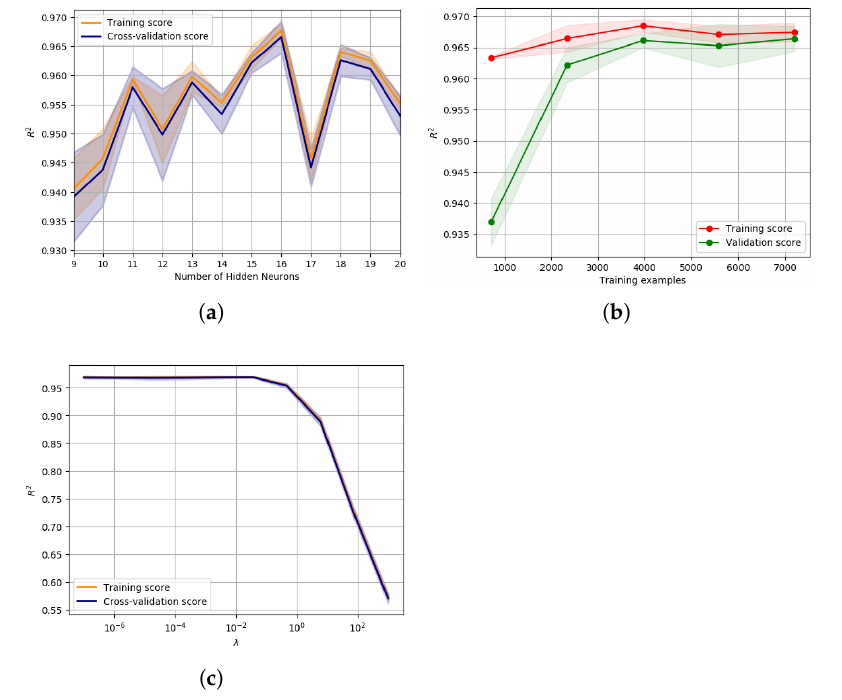
Figure 16. Analysis of ( a ) the ANN-model hidden layer size, ( b ) training sample database size and ( c ) regularization term λ